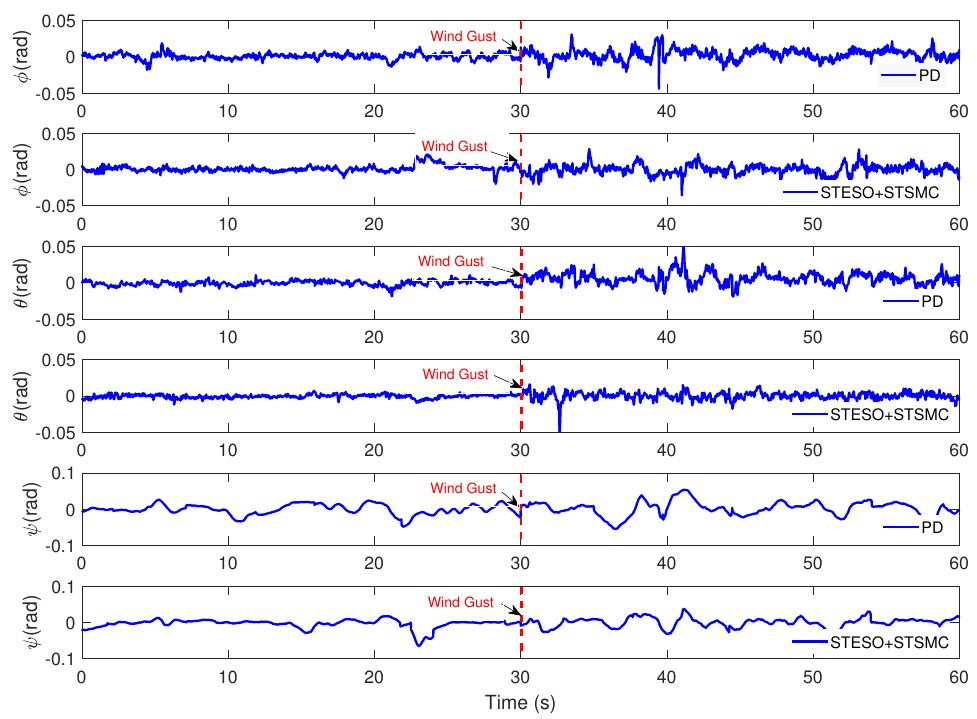
Figure 15. Experimental curves of attitude angle φ , θ , ψ in Case